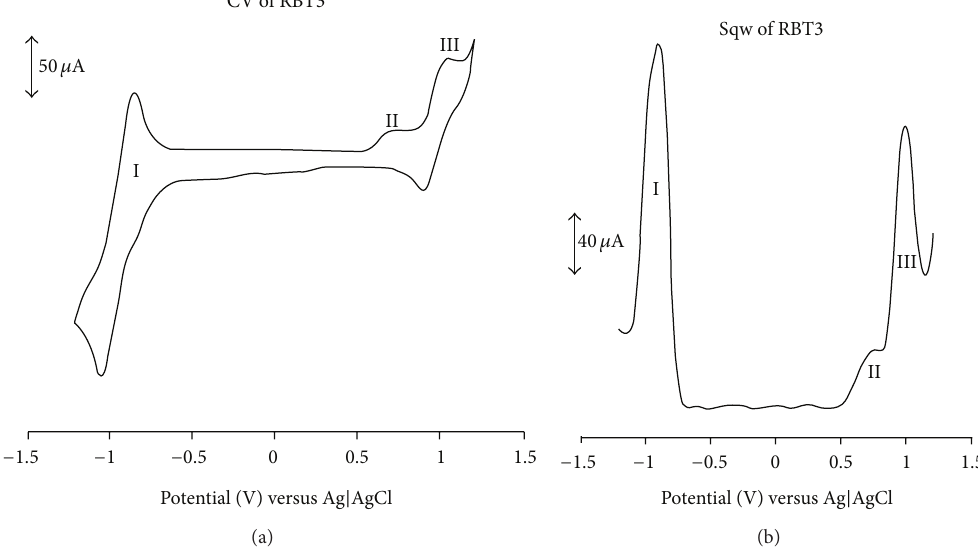
Figure 5: Cyclic and square wave voltammetry profiles of 1 × 10 −3 M of RBT3 complex in freshly distilled DMF containing 0.1 M TBABF 4 supporting electrolyte. Step potential: 5 mV, amplitude: 50 mV versus Ag | AgCl, frequency: 10Hz. Scan rate: 100mVs −1 versus Ag | AgCl.